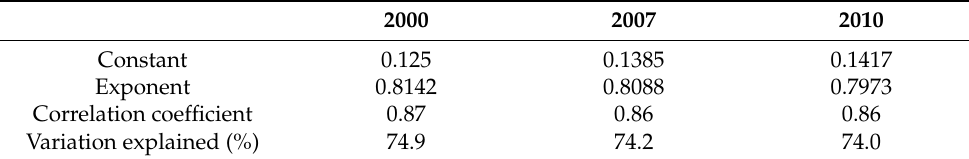
Table 3. Use of the equations in Table 2 to predict total entrepreneurship as a function of county populations in 2000, 2007, and 2010. Ratio = increase in total entrepreneurship upon a doubling of population numbers. Enterprises = total entrepreneurship. EDI = persons/entrepreneurship value.